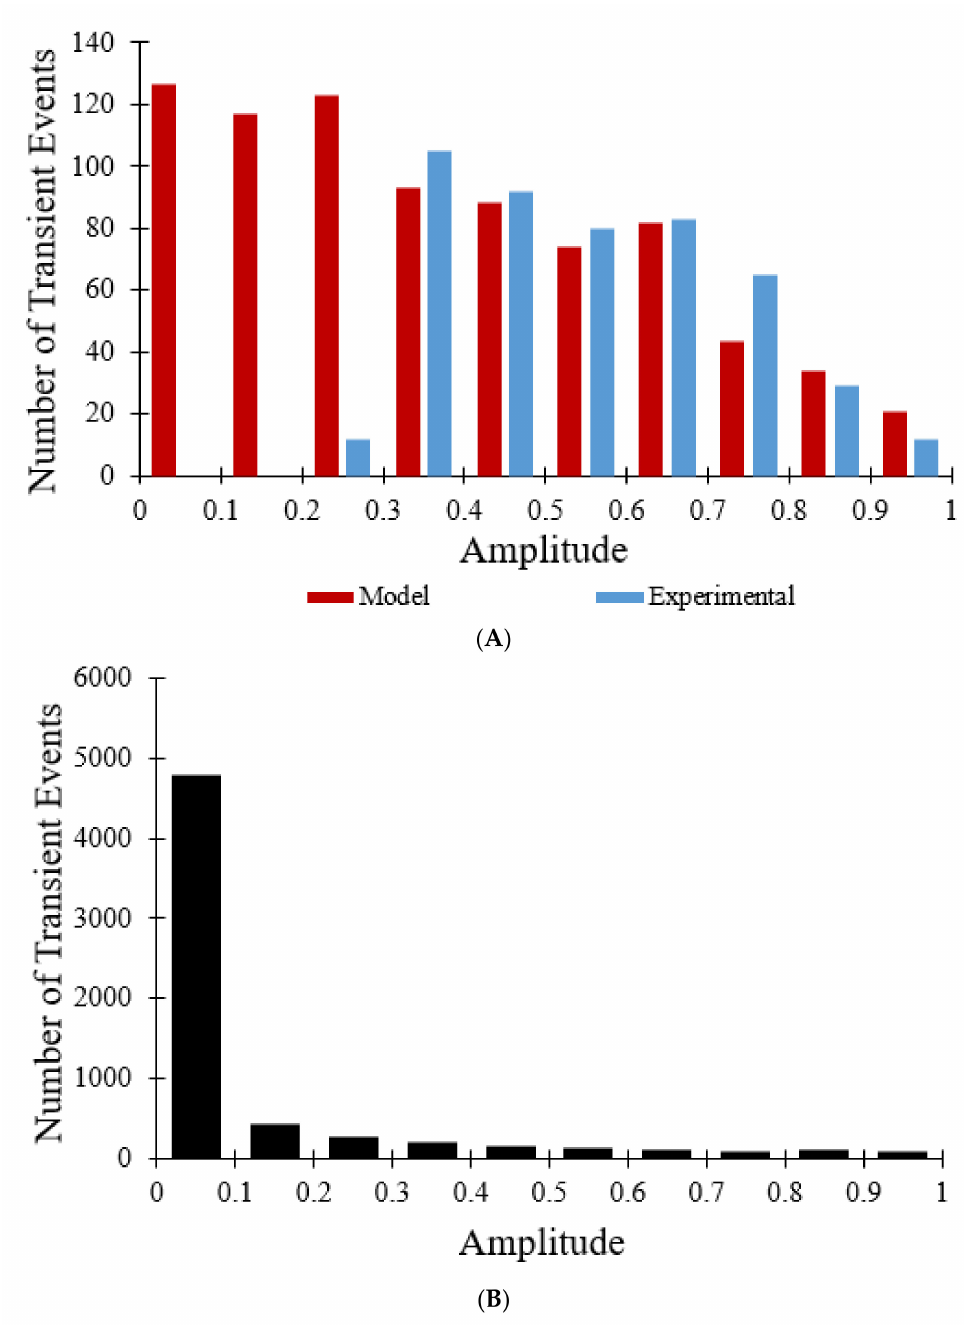
Figure 5. Amplitude distribution for transient opening events. ( A ) Experimental distribution of am- plitudes of 478 transient opening events (blue) [7]. Model distribution of amplitudes of 800 transient opening events with a 10 s sampling rate fit to data (red). ( B ) Model distribution of amplitudes of 6334 transient opening events with a sampling rate less than 0.1